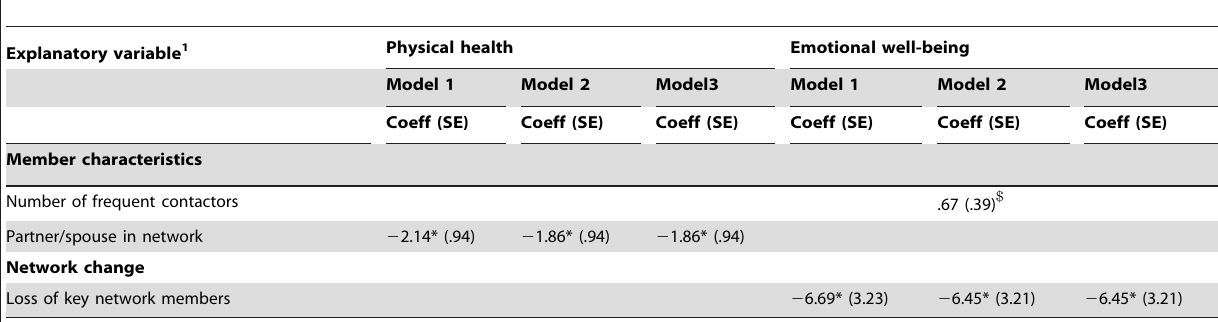
Table 6. Summary of regression analyses of changes in outcomes: Health status